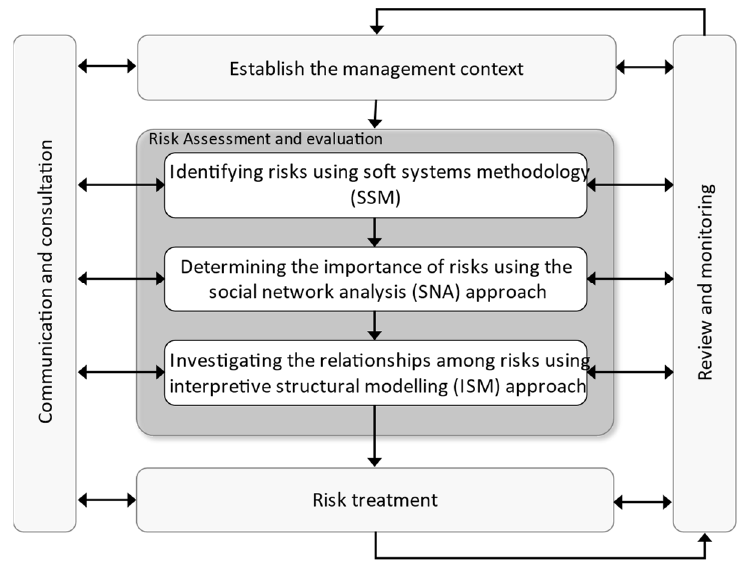
Figure 1. Steps of the proposed framework.